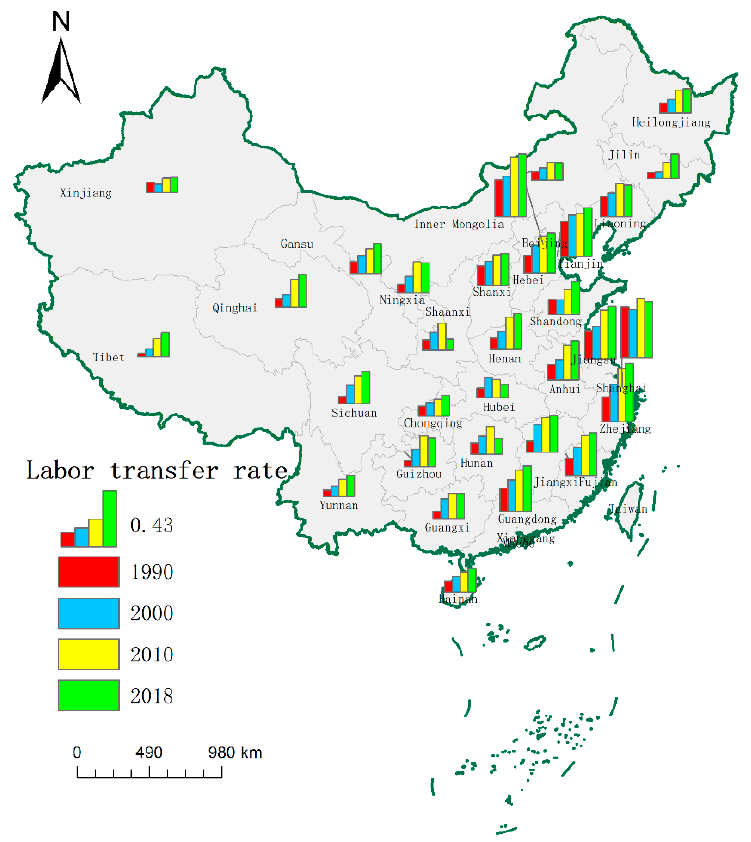
Figure 3. The spatial evolution of the labor transer.